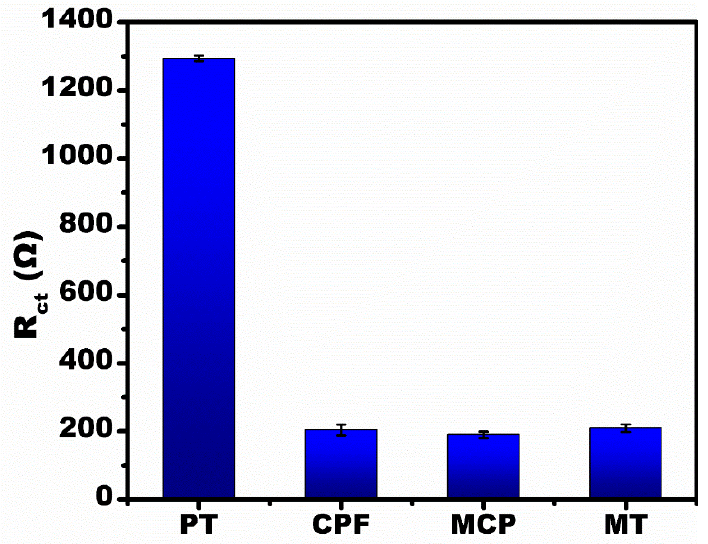
Figure 6. Selectivity studies for the developed sensor at 1 µM concentration of various OPs (PT, CPF MT, MCP).